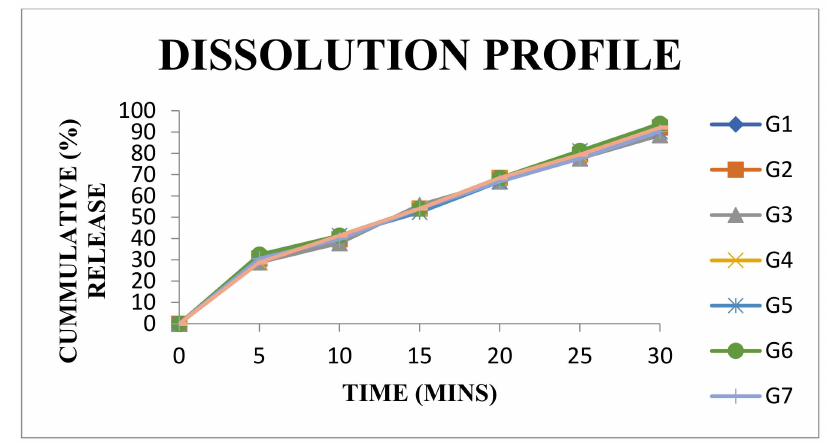
Figure 11. Comparative dissolution profiles for formulations G1 to